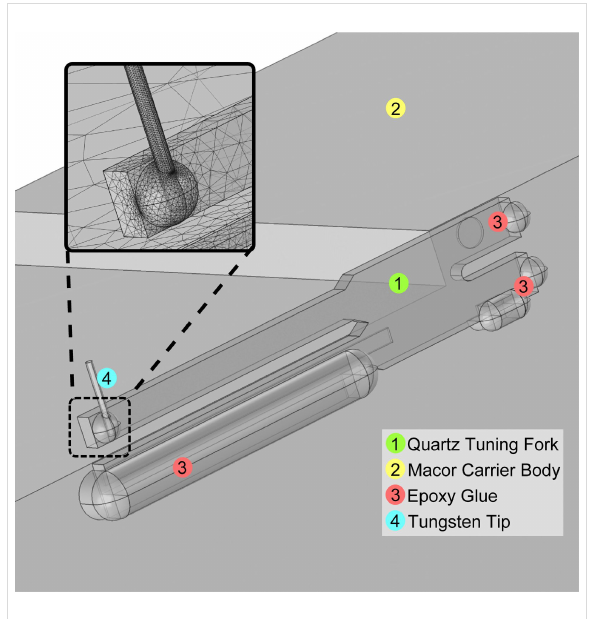
Figure 4: Image of the geometric model reflecting the geometry of an actual “qPlus” sensor. The model includes a tip (4) attached to the free prong with a droplet of epoxy glue, as well as the epoxy glue (3) at the rim and behind the tuning fork (1) fixing it to the Macor carrier (2). The